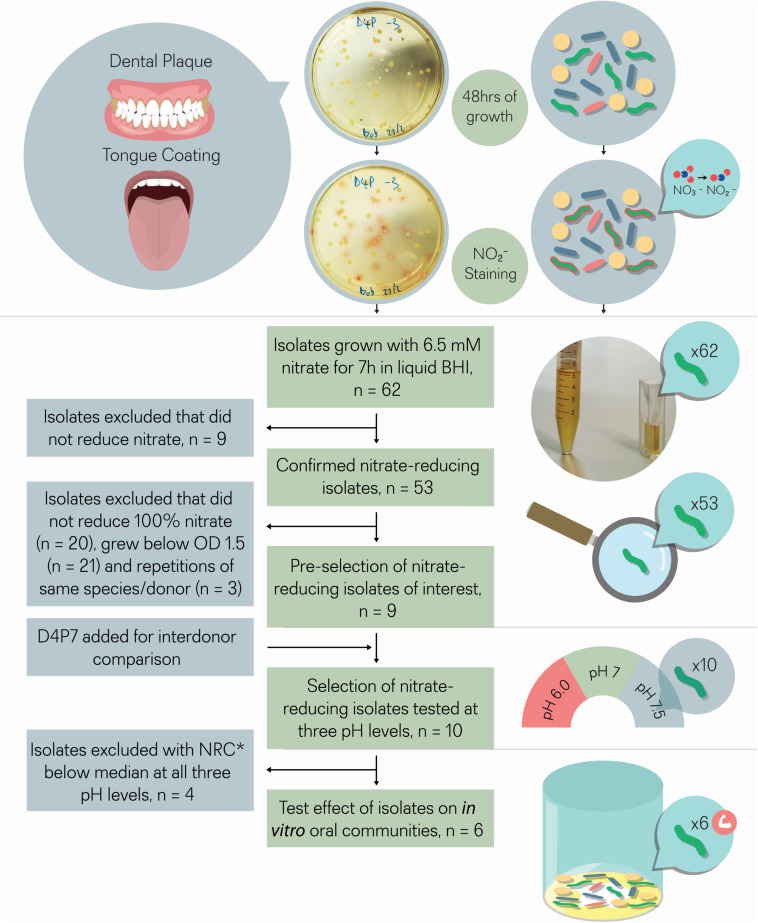
Isolate selection overview. Tongue coating and/or dental plaque samples were obtained from 5 different donors. Sixty-two colonies that produced a red color after adding Griess reagent, which stains nitrite, were isolated. The 62 isolates were incubated with 6.5 mM nitrate for 7 h for double confirmation. Nine out of 62 isolates did not reduce nitrate and were excluded, while the other 53 isolates did reduce (part of) the nitrate and were considered as confirmed cases. From these 53 isolates, nine isolates were selected that reduced all nitrate and grew well under aerobic conditions (OD > 1.5), a relevant feature for future large-scale production. One isolate (D4P7, R. dentocariosa) was added to compare nitrate reducing capacity with the three selected R. dentocariosa isolates between different donors. None of the 10 selected isolates acidified the pH of the glucose-containing medium (starting pH 7.3) below pH 6.8 after 7 h, which indicated that they were suitable probiotics from a caries point of view. The nitrate-reduction capacity of the final selection of 10 isolates was tested at three different pH levels (pH 6.5, pH 7, and pH 7.5) in buffered medium. The six isolates that reduced the nitrate-best at different pH levels were added to oral communities (from saliva) to test their effect on in vitro oral biofilm metabolism. *NRC, nitrate-reduction capacity.